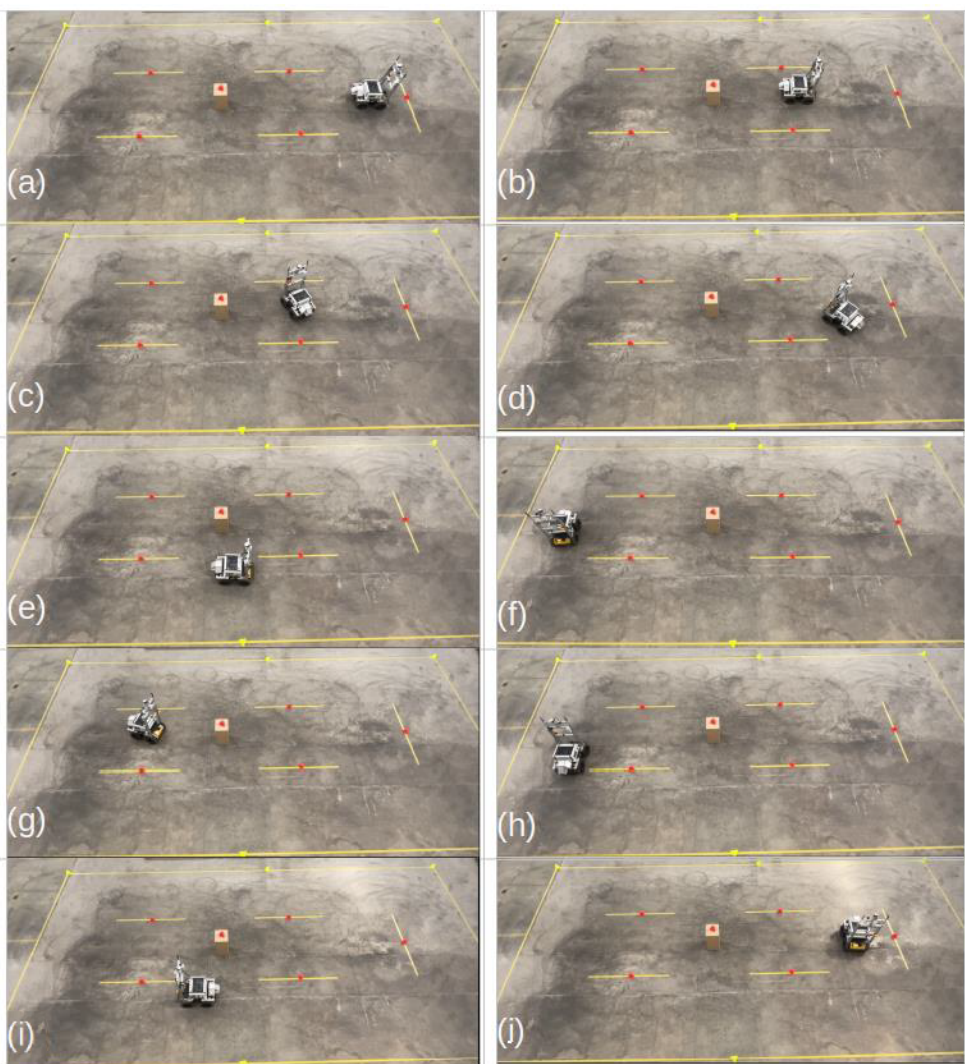
Figure 15. From ( a ) start to ( j ) end: sequence of screenshots of the simulated orchard environment with obstacles ( crop rows ) showing the navigation test of the robot prototype in the physical environ- ment, with the fixed obstacles represented by yellow lines, and the dynamic obstacle, not present in the predefined map, represented by the